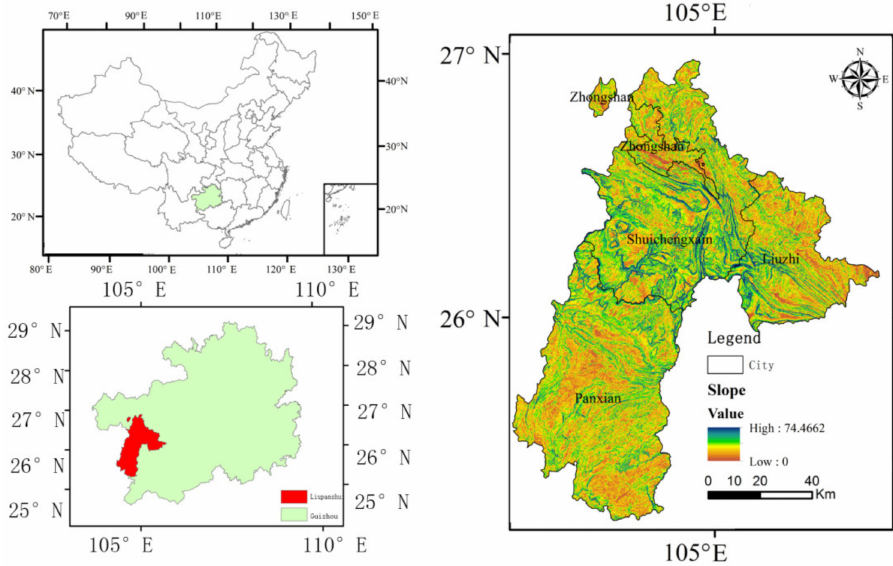
Figure 1. The map of the study